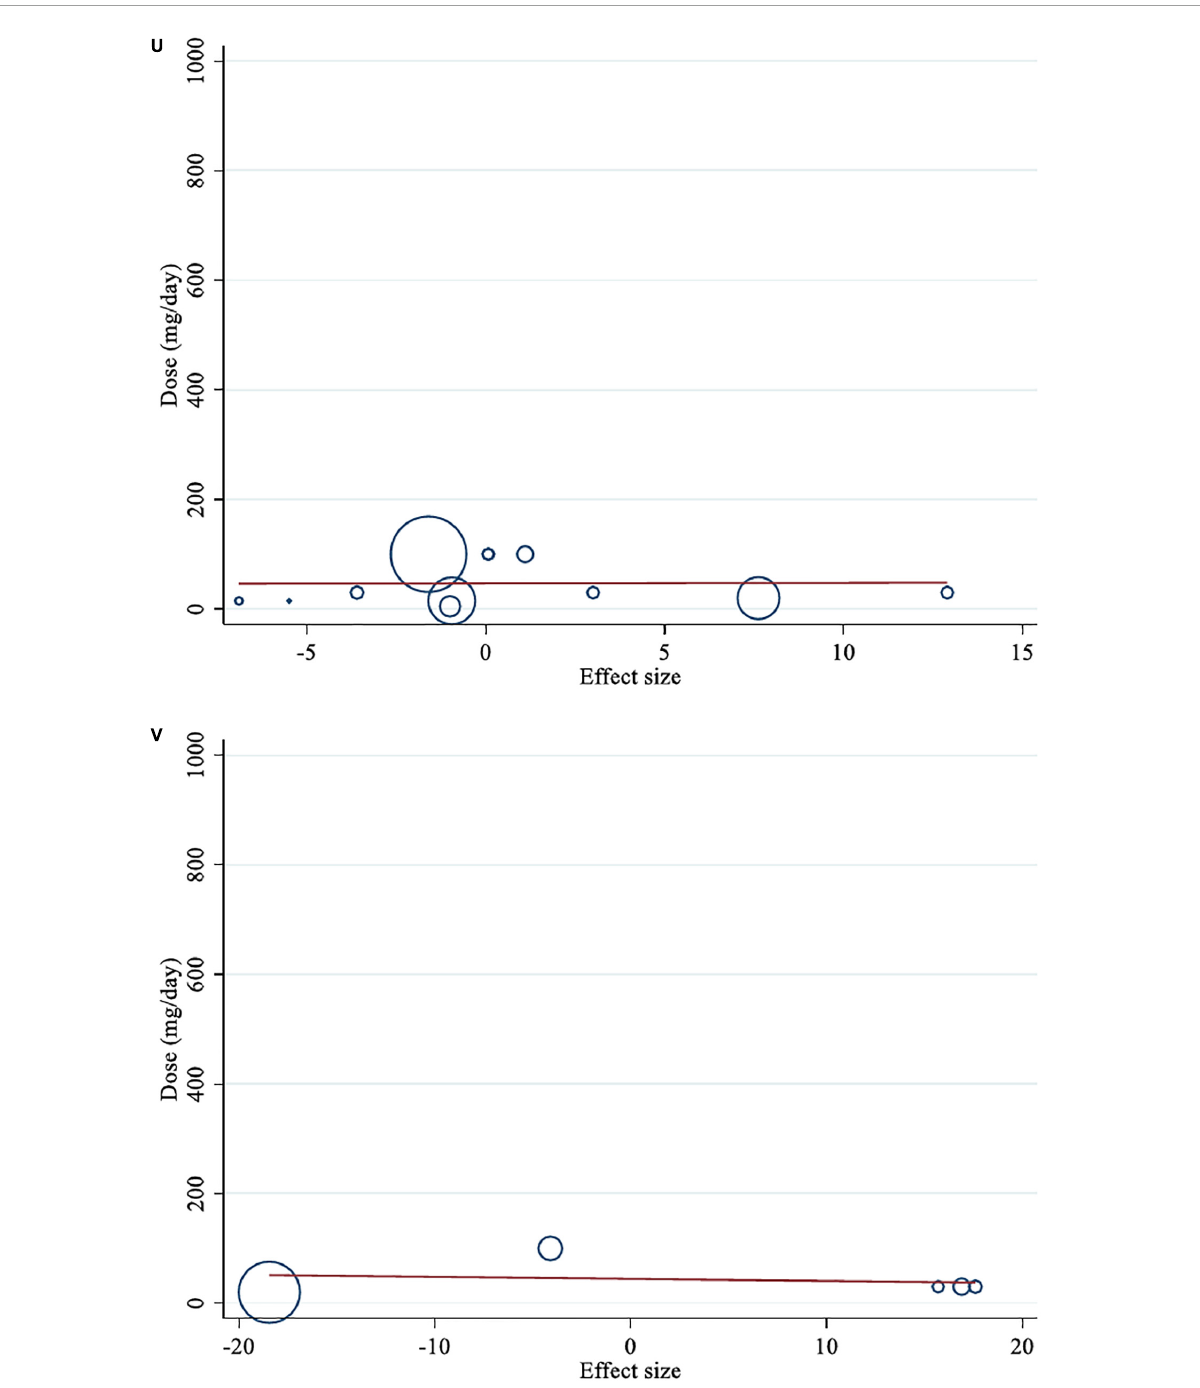
FIGURE6 Linear dose-response relations between saffron consumption and absolute mean differences. Dose-response relations between dose (g/day) and absolute mean differences (A) TG (mg/dl); (B) TC (mg/dl); (C) LDL (mg/dl); (D) HDL (mg/dl); (E) FBG (mg/dl); (F) Insulin (miu/ml); (G) HbA1c (%); (H) HOMA-IR; (I) SBP (mmHg); (J) DBP (mmHg); (K) CRP (mg/l); (L) ; IL-6 (pg/ml); (M) TNF- α (pg/ml); (N) weight (kg); (O) BMI (kg/m 2 ); (P) WC (cm); (Q) FM (%); (R) MDA (uM/L); (S) TAC (mM/L); (T) ALT (U/L); (U) AST (U/L) and (V) ALP (U/L). TG, triglyceride; TC, total cholesterol; LDL, low-density lipoprotein; HDL, high-density lipoprotein; FBG, fasting blood glucose; HOMA-IR, homeostasis model assessment for insulin resistance; HbA1C, hemoglobin A1C; CRP, C-reactive protein; IL-6, interleukin 6; TNF- α , tumor necrosis factor; TAC, total antioxidant capacity; BMI, body mass index; WC, waist circumference; FM, fat mass; ALT, alanine transaminase; AST, aspartate transaminase; ALP, alkaline phosphatase; MDA, malondialdehyde ; SBP, systolic blood pressure; DBP, diastolic blood pressure; CI, confidence interval; WMD, weighted mean